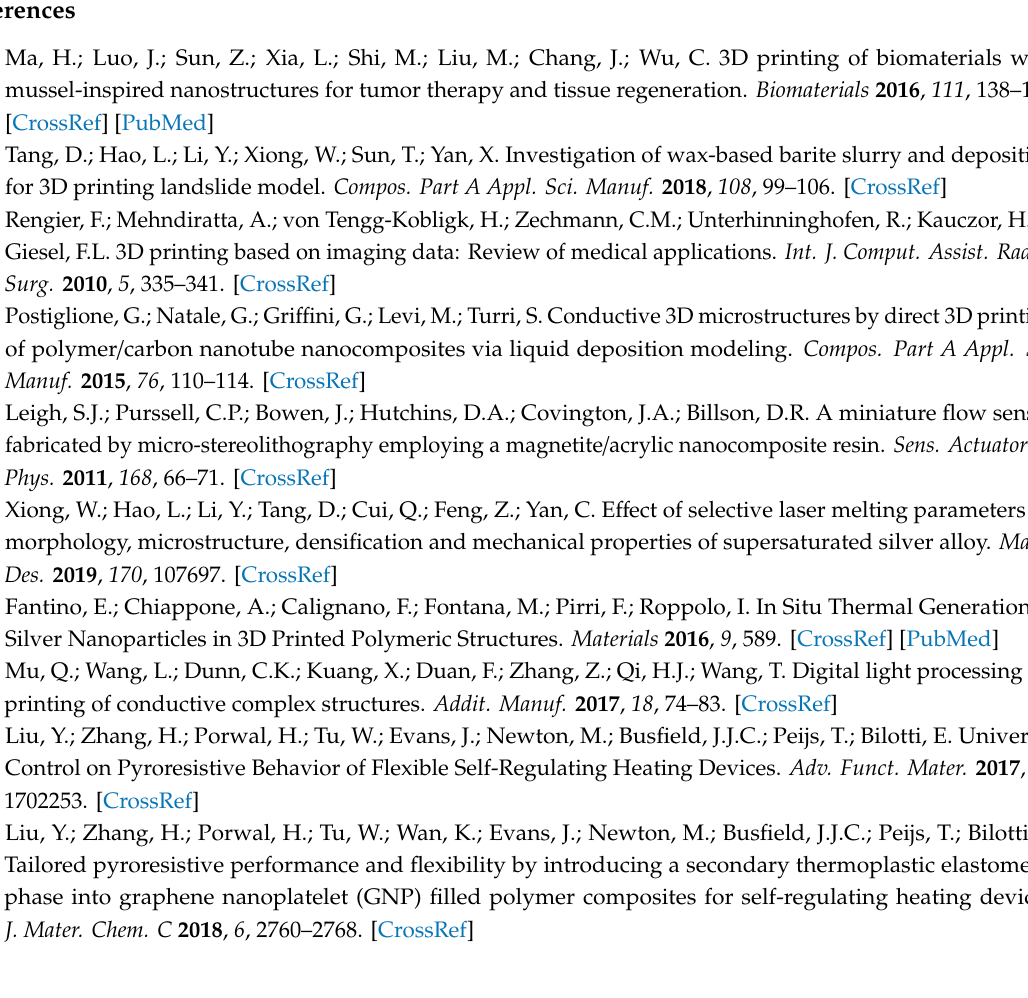
Figure S1: Schematic of the K IC specimen, Figure S2: FTIR spectra of 0.5 wt.% graphene-reinforced nanocomposites, Figure S3: Halpin-Tsai models with Mori–Tanaka modified shape factor of composite modulus ratio Ec / Em as a function of filler aspect ratio together with experimental data of 0.03 Vol% graphene nanocomposites. Model predictions assumed for platelet moduli of 780 GPa with a 2D planar or 3D random orientation, Figure S4: The K IC value and optical images of failed fracture toughness test specimens for the neat resin with 30 ◦ sharp notch tips, Figure S5: Optical microscopy images of fracture surface and fractured lateral view of graphene / resin composites after a failed fracture toughness test (a,b) the neat resin specimens; (c,d) 0.5 wt.% nanocomposites specimens; SEM images of the fracture surfaces of 0.5 wt.% nanocomposites specimens after a failed fracture toughness test (e) magnification of the circled domain in (c) and (f) magnification of the circled domain in